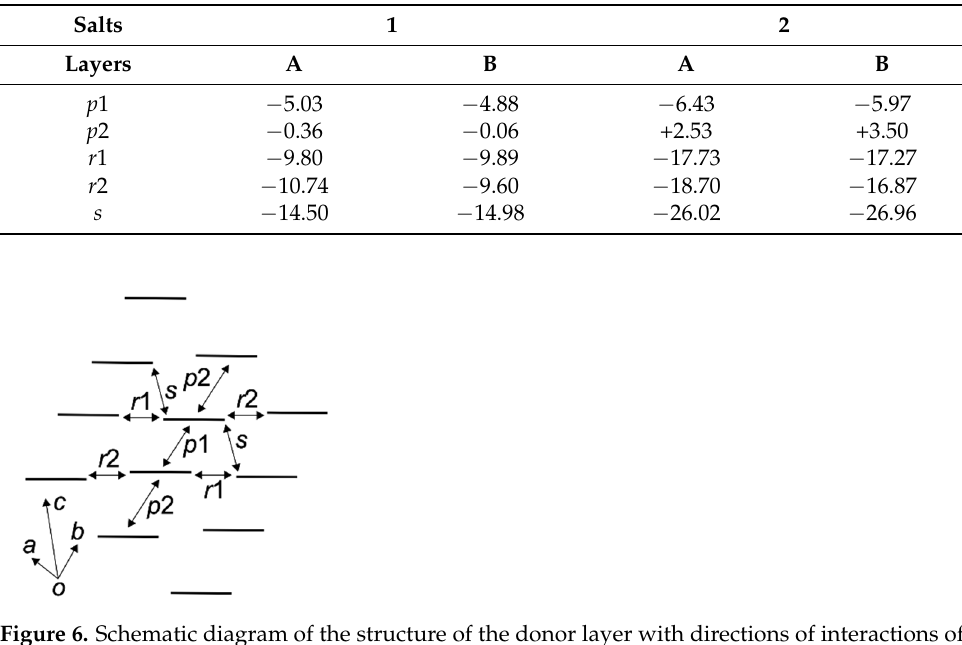
Table 2. Overlap integrals ( × 10 − 3 ) of 1 and 2 at 150 K.